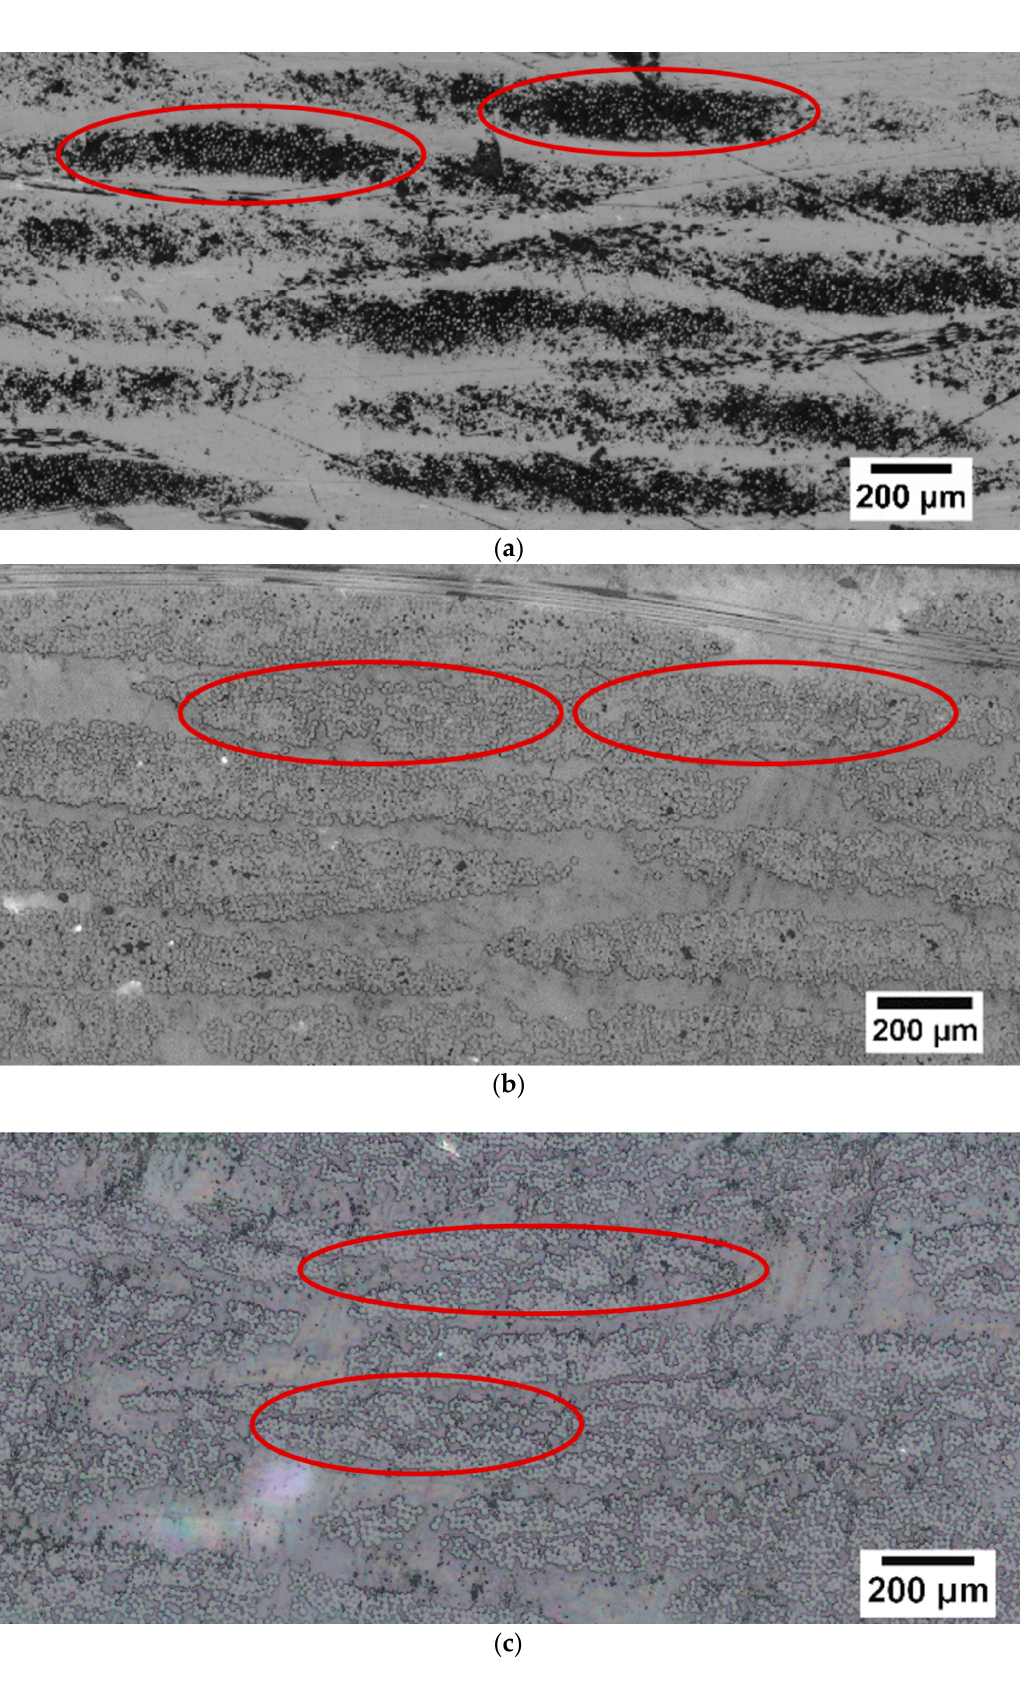
Figure 3. Varying degrees of impregnation observed through optical microscope images of BF-PC composites processed at pre-consolidation temperatures of ( a ) 170 °C (u), ( b ) 260 °C, and ( c ) 280 °C. Table 4. Tensile and flexural properties of the UD basalt fibre PC composites.